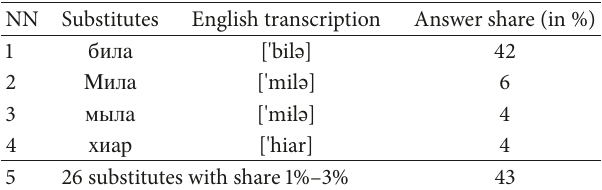
Figure 3: a statistically significantly higher (at the level of 95%) value of utterance miss (false negative error) for German (depending on the characteristics of the speaker) is marked with a frame), which demonstrates the effect of the language (and its acoustic characteristics) of the utterance on detection and recognition of the utterance in